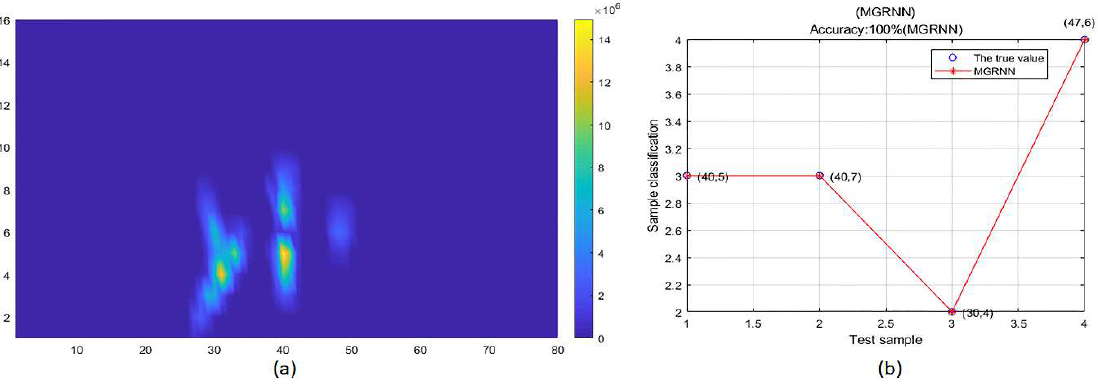
Figure 19. Four interference sources with different frequencies at 3 GHz, 3 GHz, 2 GHz and 4 GHz. ( a ) original image; ( b ) result of classification.